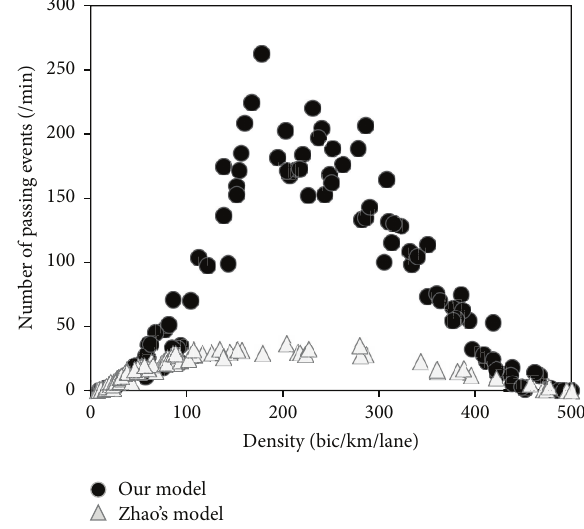
Figure 6: Simulation of number of passing events.